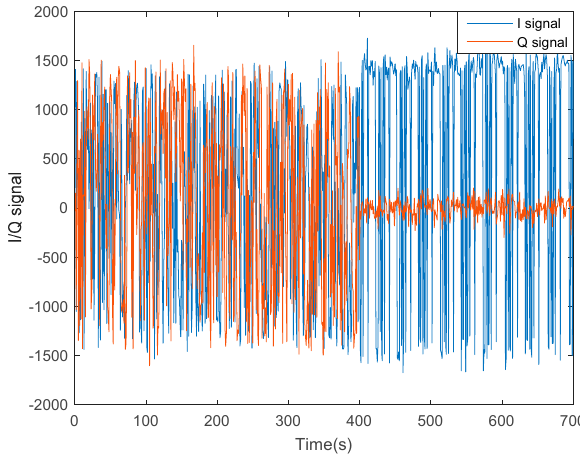
Figure 7. I/Q Signals of Beidou B1 from a stable oscillatory loop. Figure 7. I / Q Signals of Beidou B1 from a stable oscillatory